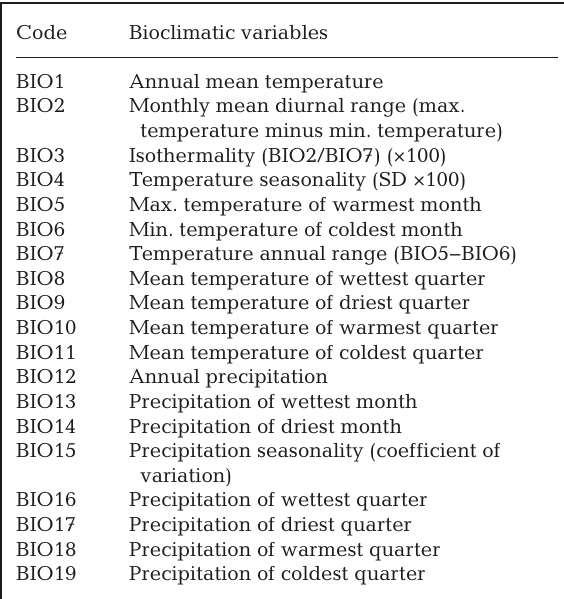
Table 1. Bioclimatic variables used in the variable selection strategy to build a climate similarity model for Polypterus